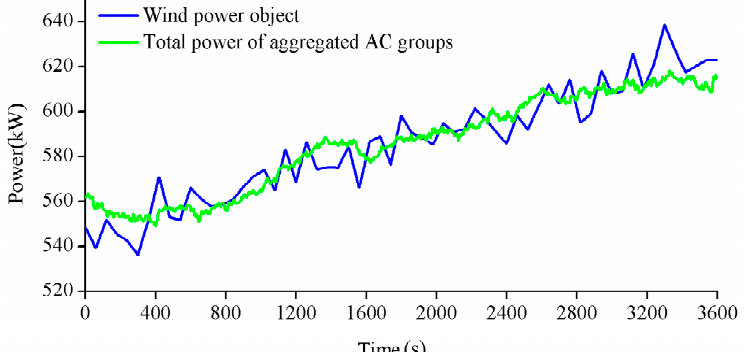
Figure 4. Wind power tracking target and estimated total power of aggregated AC groups.